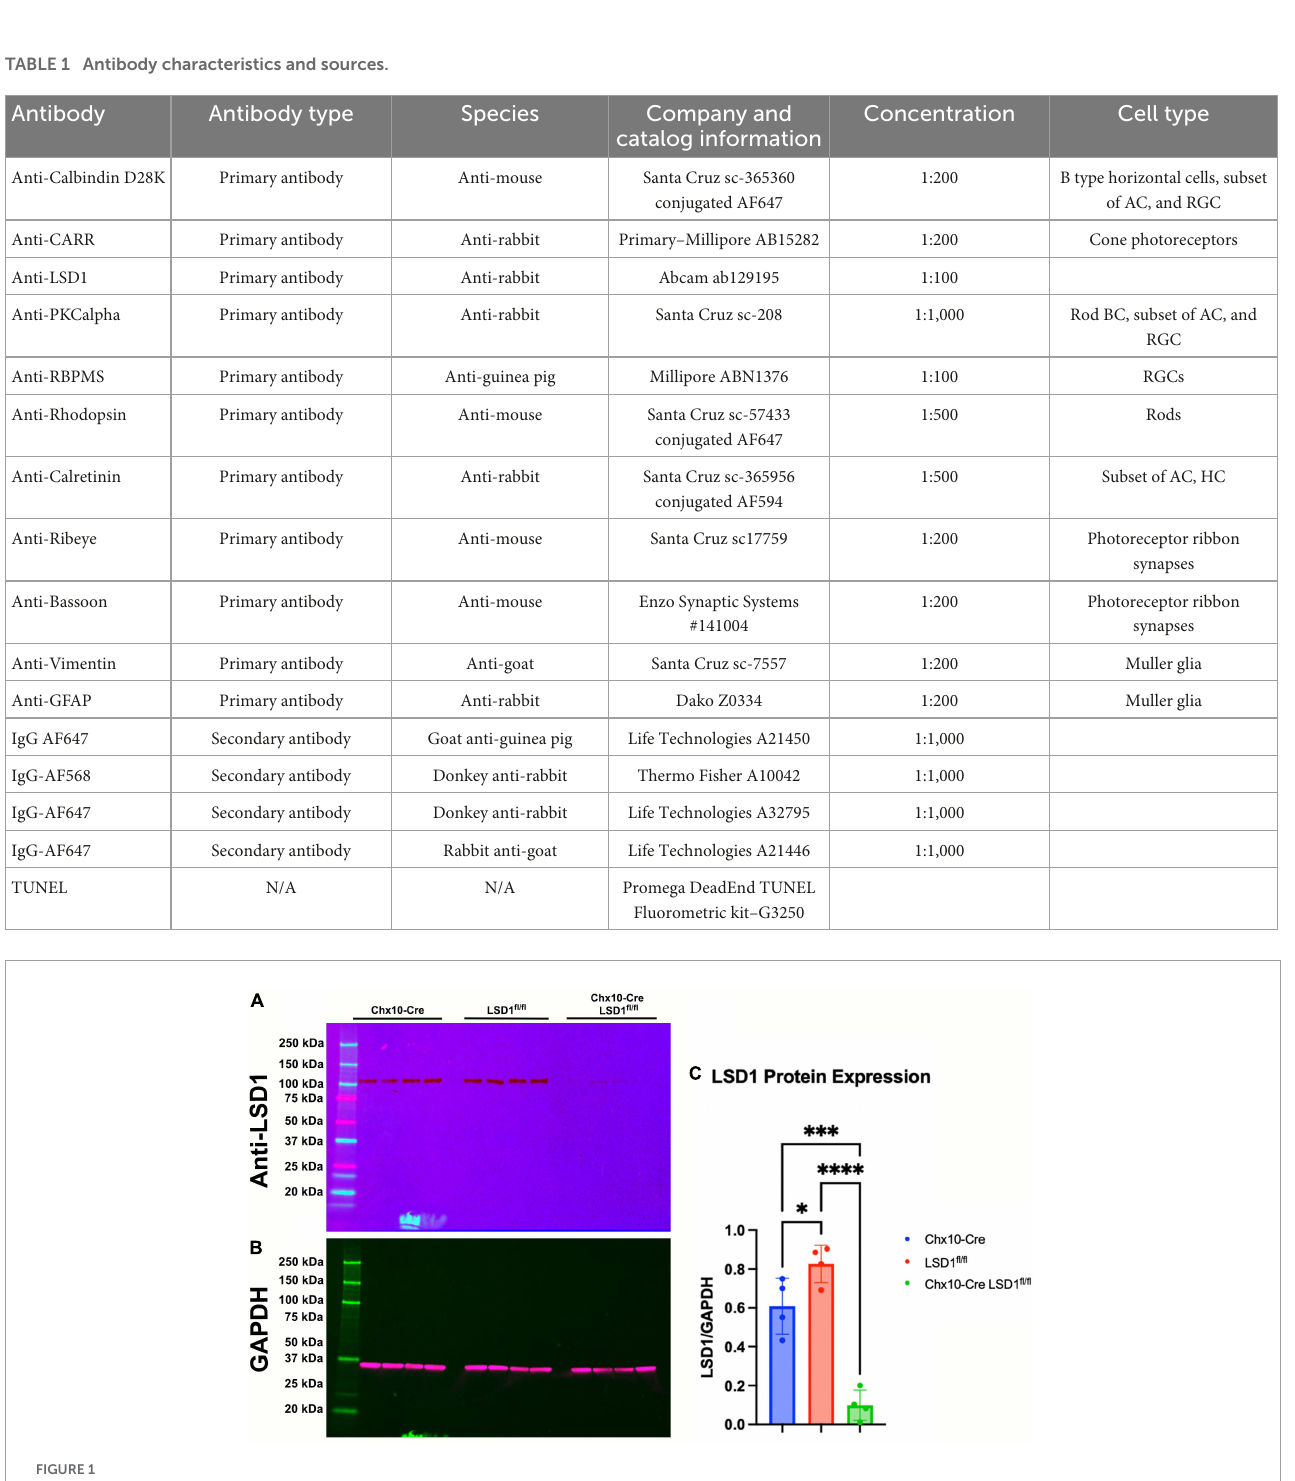
FIGURE1 Western blot confirming LSD1 deletion in P30 retinas. Retinas from Chx10-Cre only, Lsd1 fl / fl only, and Chx10-Cre Lsd1 fl / fl were probed with a anti-LSD1 antibody [1:1,000] (A) and an anti-GAPDH antibody [1:1,000] (B) as a loading control. In the two control groups, Chx10-Cre and Lsd1 fl / fl only, the full length LSD1 (molecular weight: 107 kDa) was detected, with no other extraneous bands, indicating the high specificity of this antibody. Densitometric quantification showed a statistically significant decrease in protein expression in the Chx10-Cre Lsd1 fl / fl samples compared to both control groups (C) . One–Way ANOVA with Tukey’s multiple comparisons test. *Represents p -value < 0.05; ***represents p -value < 0.001; and ****represents p -value < 0.0001. Sample sizes: Chx10-Cre ( n = 4), Lsd1 fl / fl only ( n = 4), and Chx10-Cre Lsd1 fl / fl ( n = 4). Full list of statistical results can be found in Supplementary Table 1